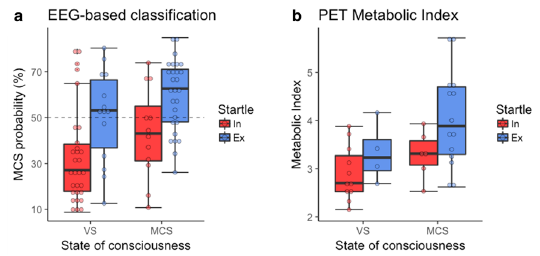
Fig. 1 Main effect of the ASR response on EEG‑based classification and PET metabolic